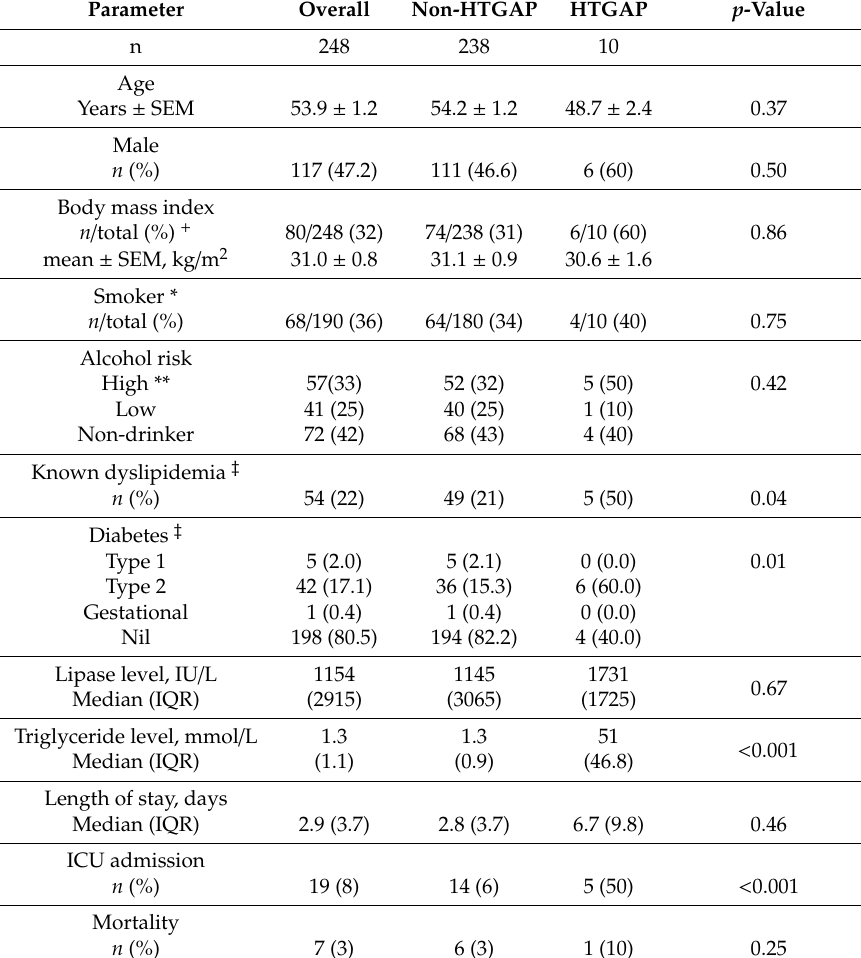
Table 1. Demographic and clinical data comparing hypertriglyceridemia-associated acute pancreatitis (HTGAP) and non-HTGAP